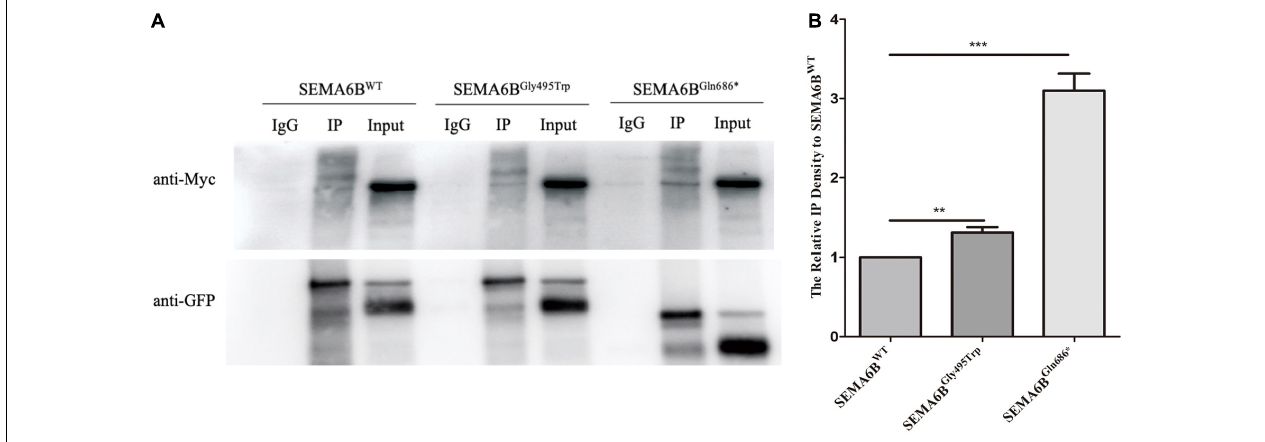
FIGURE 5 | Protein binding of PlxnA2 and SEMA6B. (A) The pulled-down Myc-PlxnA2 increased in SEMA6B Gly495Trp and SEMA6B Gln686 ∗ compared to wild type as shown by Co-IP analysis. (B) Densitometric analysis of Myc-PlxnA2. Values were normalized using GFP. Three independent experiments were performed for each condition ( N = 3, ** P < 0.05, *** P <